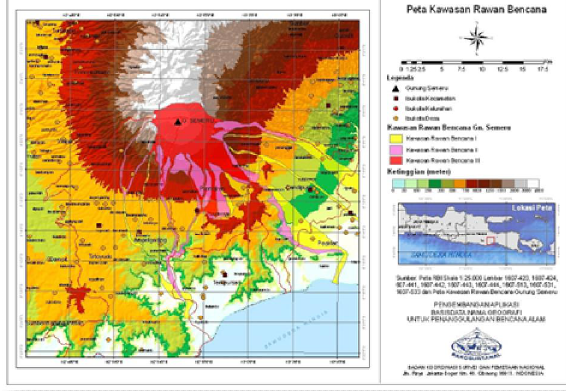
Figure 3. Map of Disaster Prone Area of Mt. Semeru with Geographical Names that have been verified